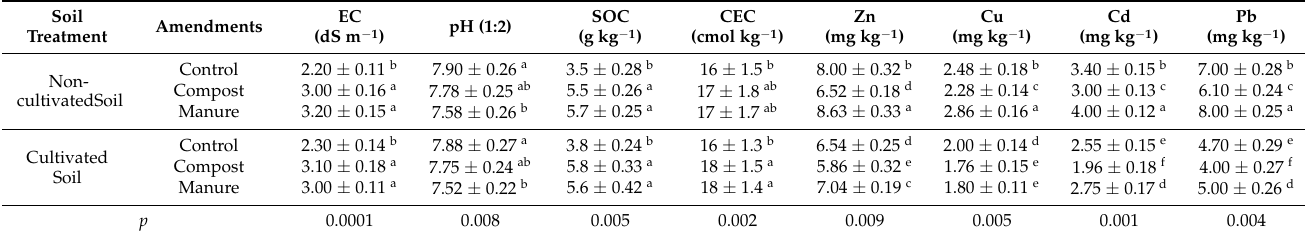
Table 3. Effect of cultivation, compost, and manure on some chemical characteristics of soil.